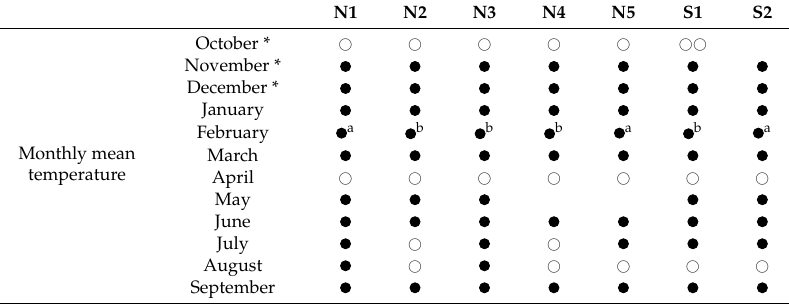
Table 2. Pearson correlation coefficients between population density dynamics of Larix in seven sampling sites in the alpine treeline ecotone in the Eastern Tibetan Plateau and the monthly meteorological data during the period of 1971–2014. The months marked with “*” denote months belonging to the previous year. “ a ” marked at the top right of the circles denotes significance at p < 0.05, and ” b ” denotes significance at p < 0.01. N1 N2 N3 N4 N5